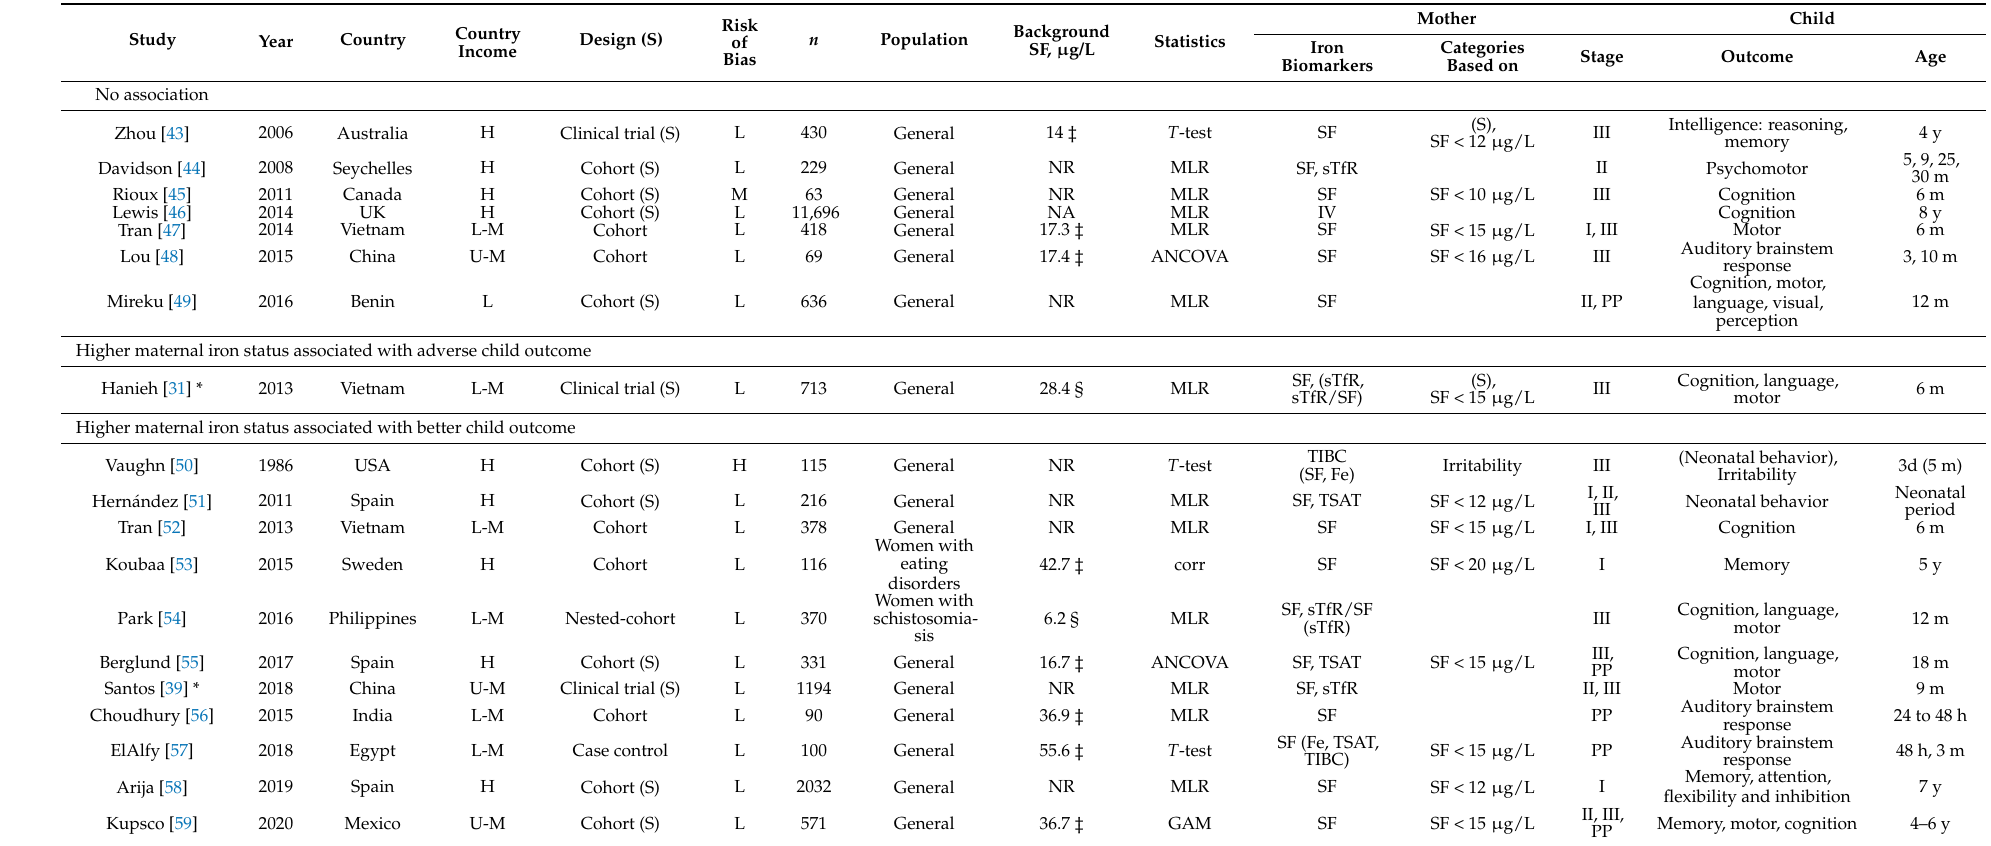
Table 3. Studies on maternal iron status and child neurobehavioral